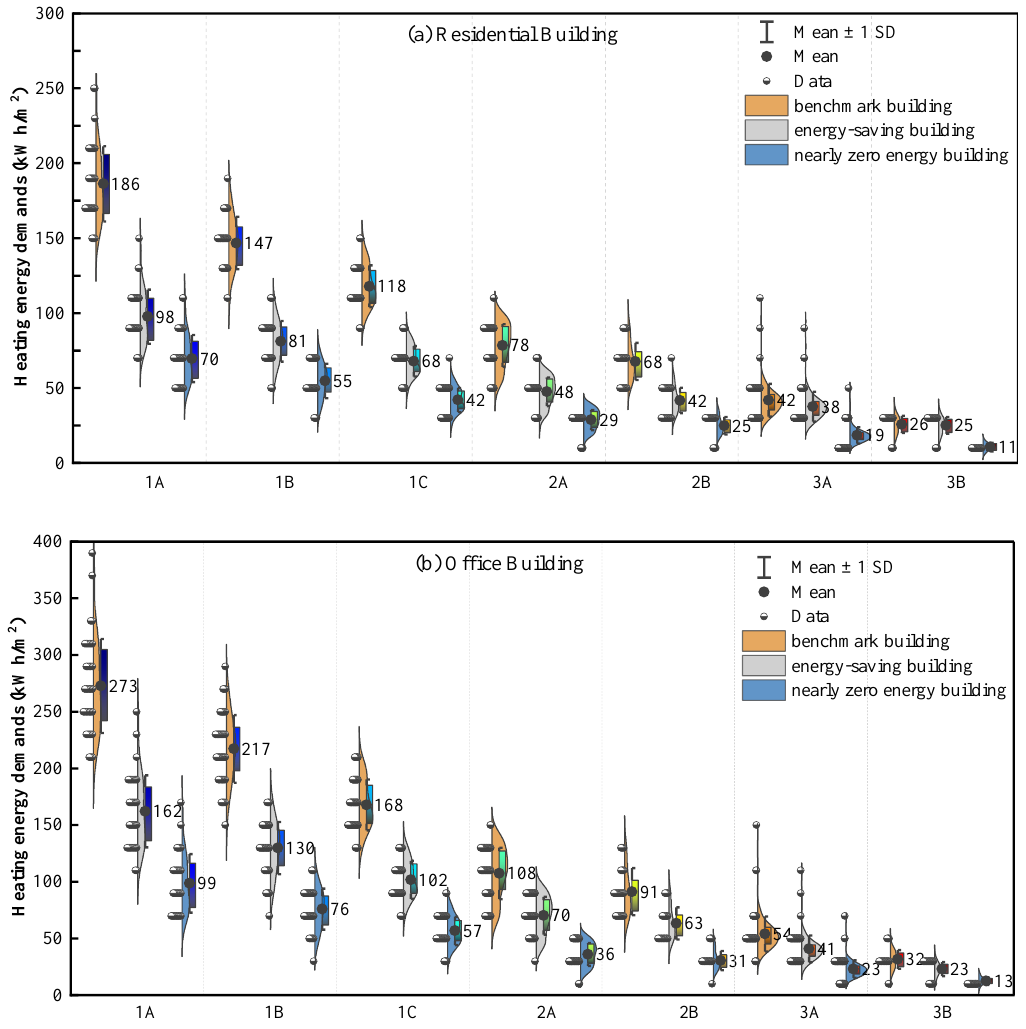
Figure 10. Distribution of annual heating loads for ( a ) residential buildings and ( b ) office buildings built according to different standards.